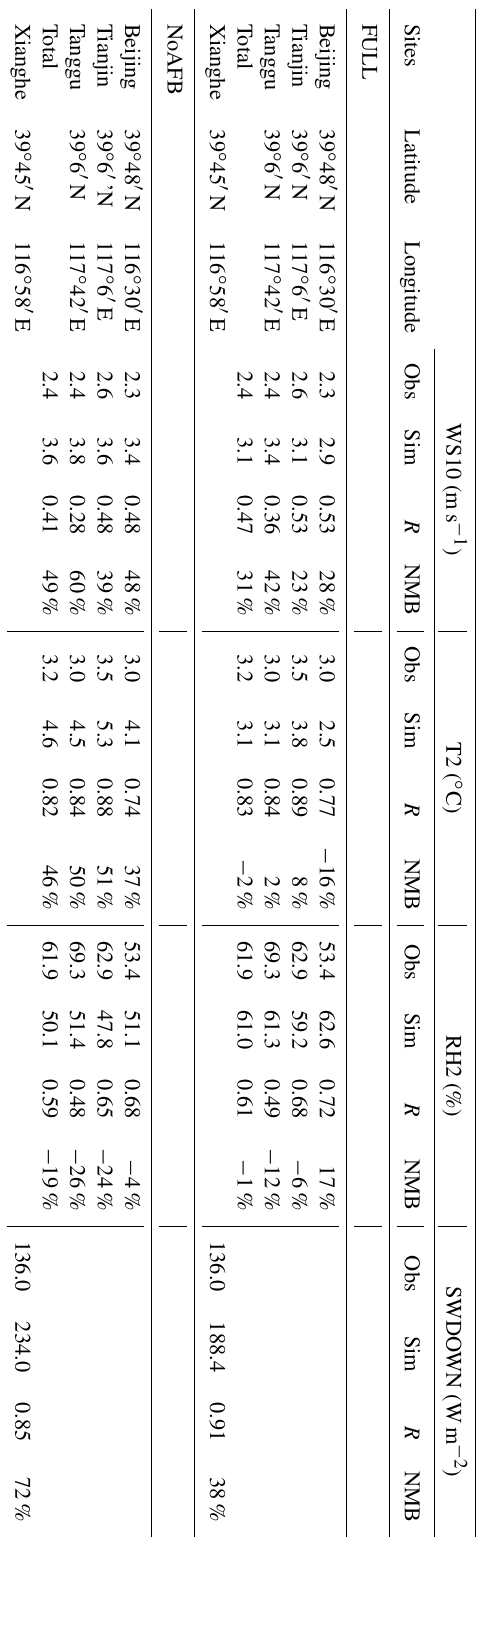
upper troposphere. Such overpredictions are also found for the same region in previous studies, such as WRF-Chem sim- ulations (Gao et al., 2016). The statistics indicate that the model-simulated vertical distribution of meteorological vari- ables are within an acceptable accuracy range of current me- teorological model